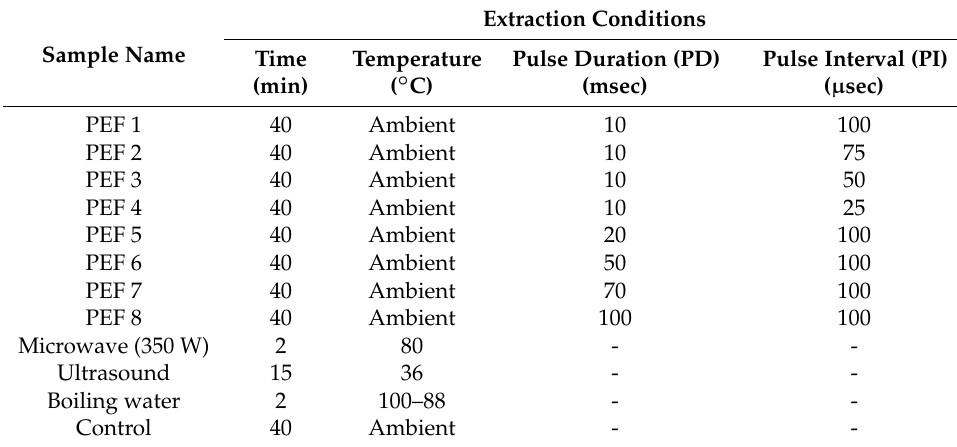
Table 1. Sample names and extraction